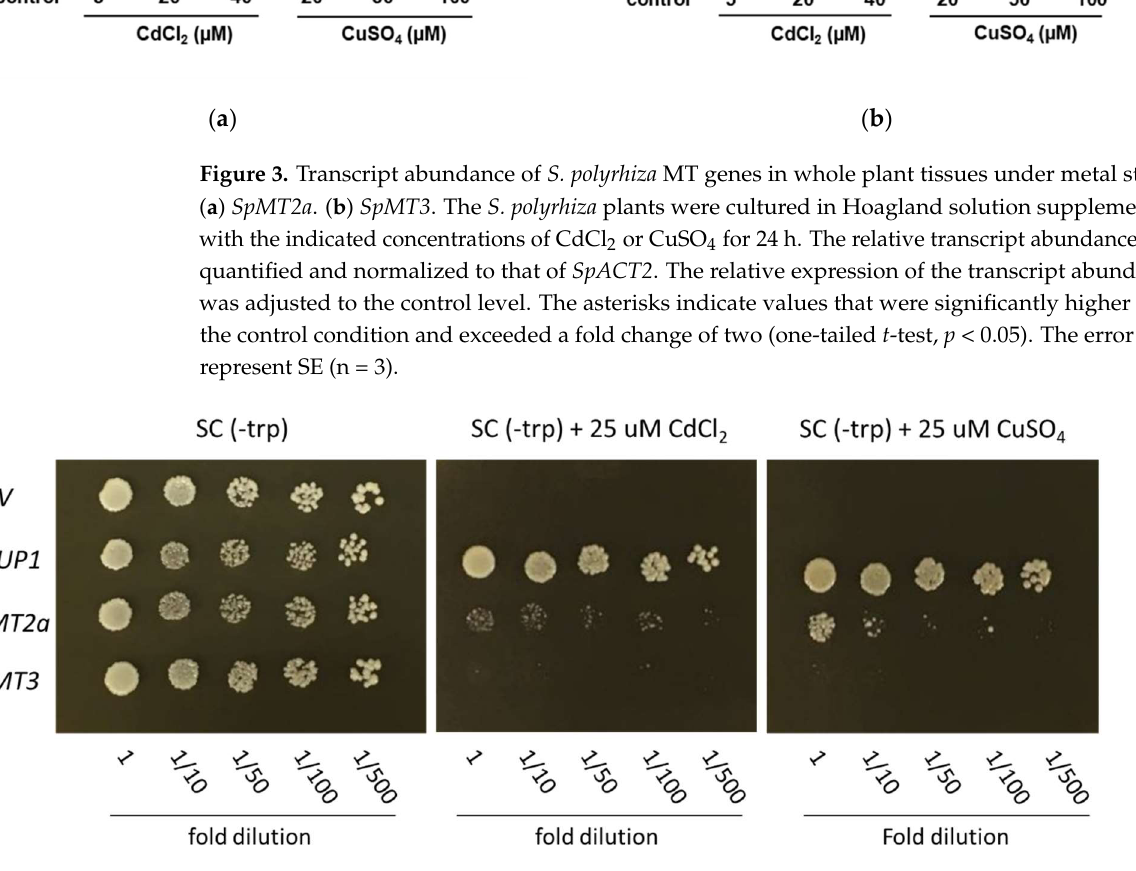
Figure 4. Metal sensitivity of the S. cerevisiae ∆ cup1 strain expressing the SpMT2a and SpMT3 genes in comparison to the controls: empty vector (EV) or S. cerevisiae CUP1 (Sc CUP1 ). Serially diluted yeast cultures were spotted on normal SC(-trp) agar or the medium supplemented with 25 µM CdCl 2 or 25 µM CuSO 4 for 3 days .